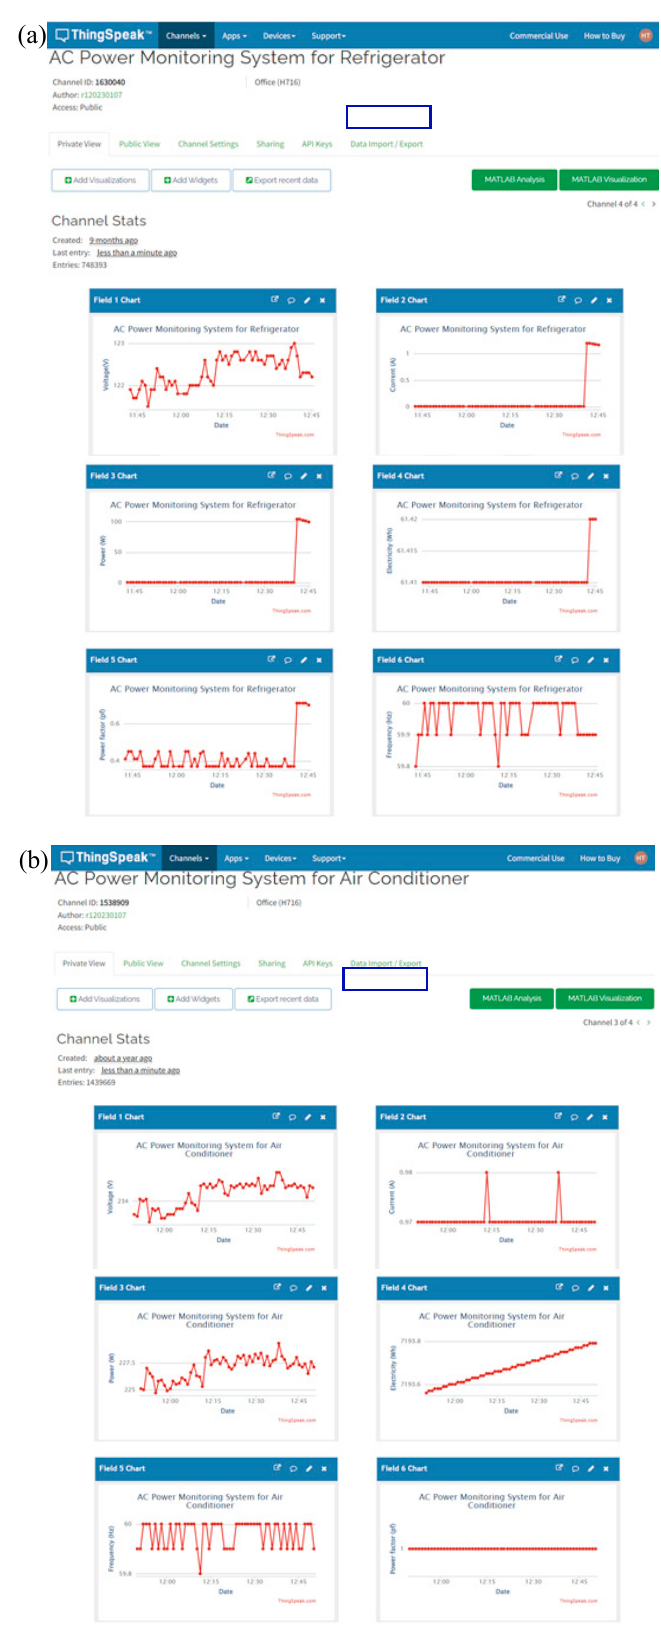
Figure 9. Parameter visualization of voltage, current, electrical power and energy, pf, and frequency in the ThingSpeak: ( a ) Refrigerator; ( b ) Air conditioner.